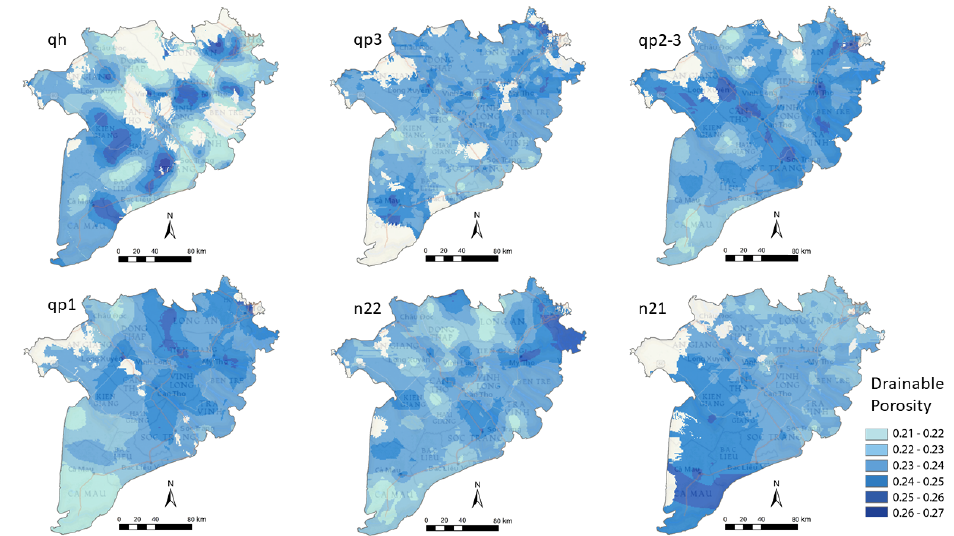
Figure C1. Maps of layer-average drainable porosity for aquifers in the MKD as obtained from ordinary kriging. In blank areas the aquifer is not